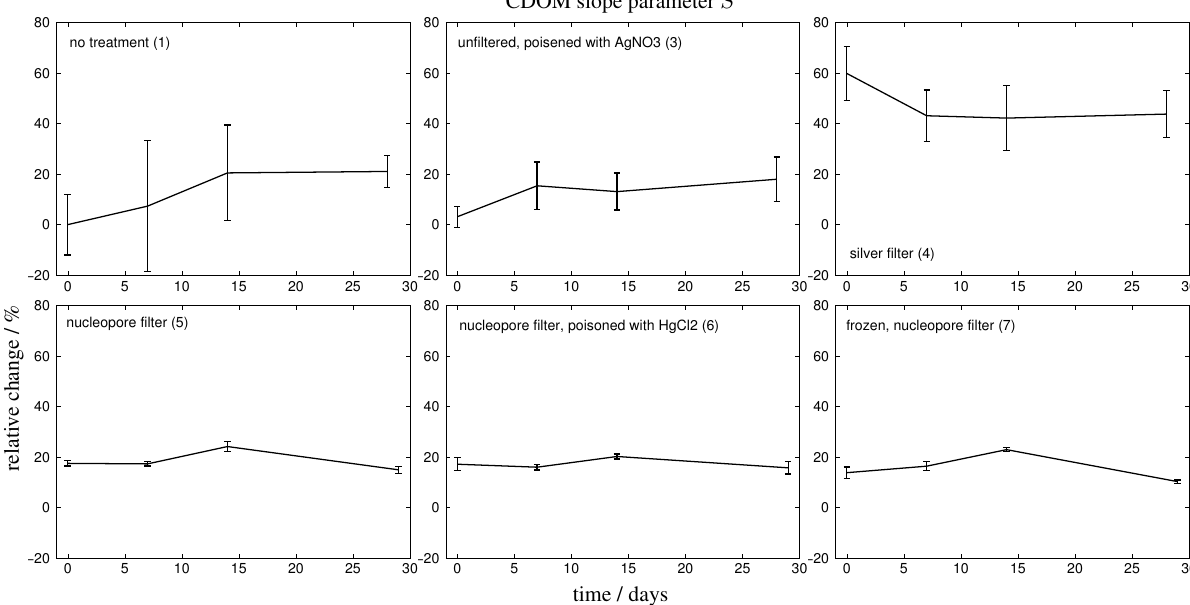
Fig. 3. Relative change of CDOM slope parameter S in respect to “No treatment” at t 0 vs. storage time for SML samples collected from the Tyne estuary for different treatments as detailed in Tab. 1. Differences at t 0 are caused by treatment effects. Treatments are labelled in each figure.